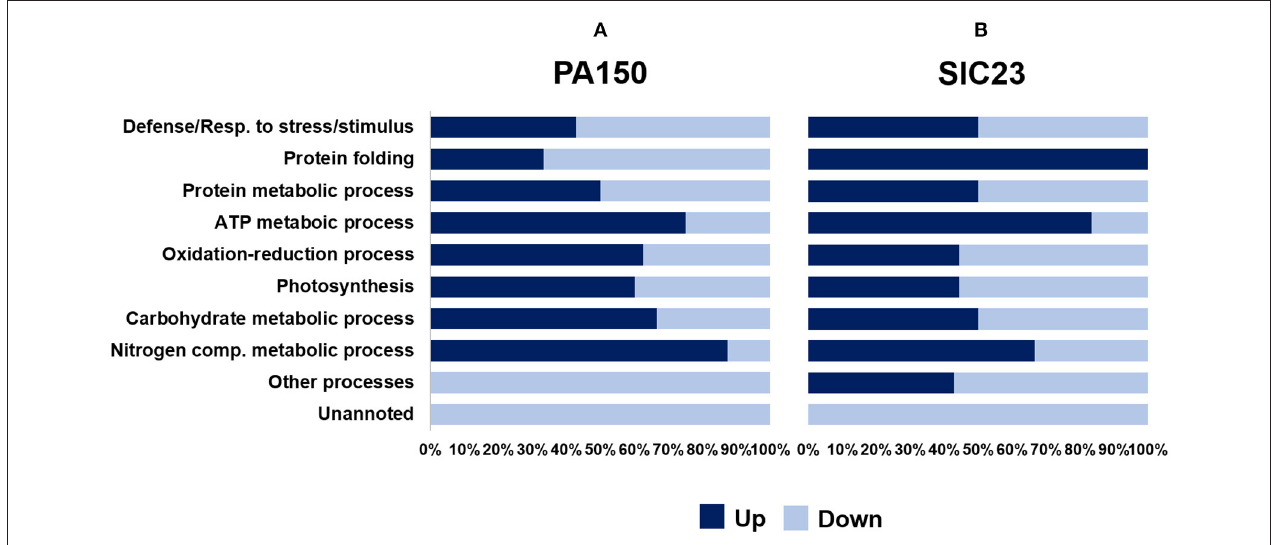
FIGURE 2 | Classification by category of proteins identified in cacao leaves inoculated with P. palmivora . The percentage of proteins identified with increased accumulation (dark blue) and with decreased accumulation (light blue) in leaf discs from (A) resistant clone PA 150 and from (B) susceptible clone SIC 23, 48 hai with oomycete P. palmivora , in comparison to their